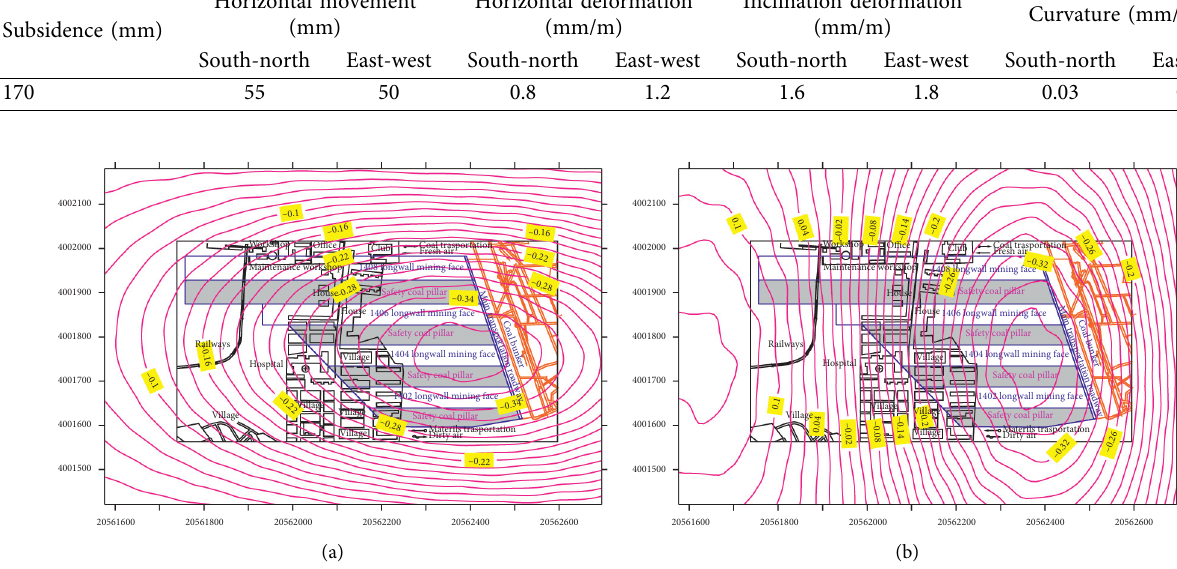
Figure 10: Contour map of horizontal surface deformation in strip mining.